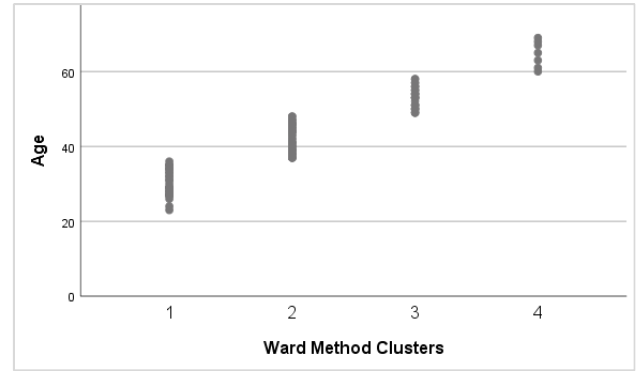
Figure 8. Age of drivers in clusters based on their reaction times. Source: own collaboration. Mean reaction times and ages of the drivers in the created clusters are shown in Table 5. Table 5. Reaction times and ages of the drivers in the created clusters.